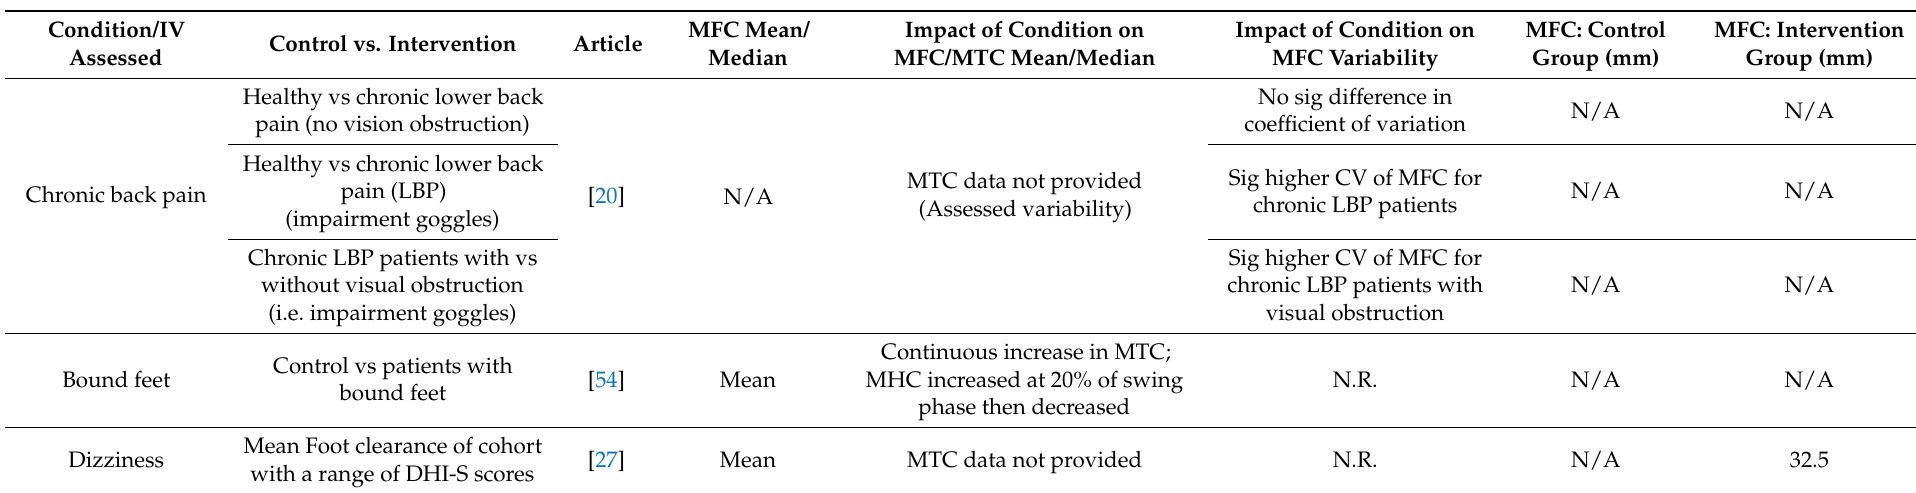
Table 5. Summary of findings in included papers for conditions in “other”